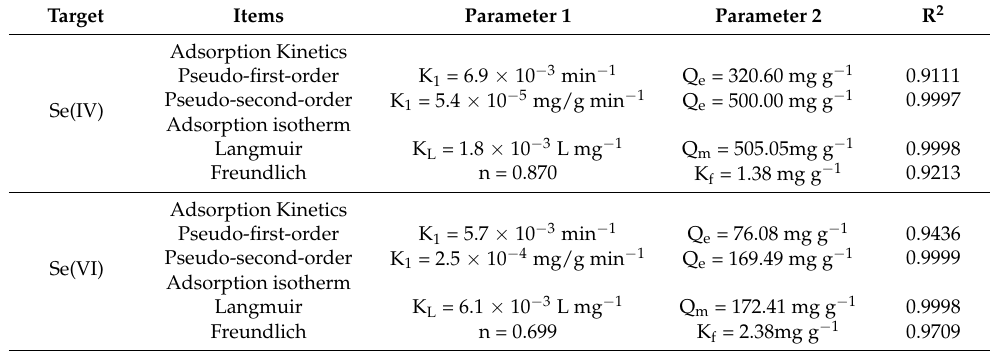
Table 1. Fitting results of the sorption isotherms and sorption kinetics for selenite and